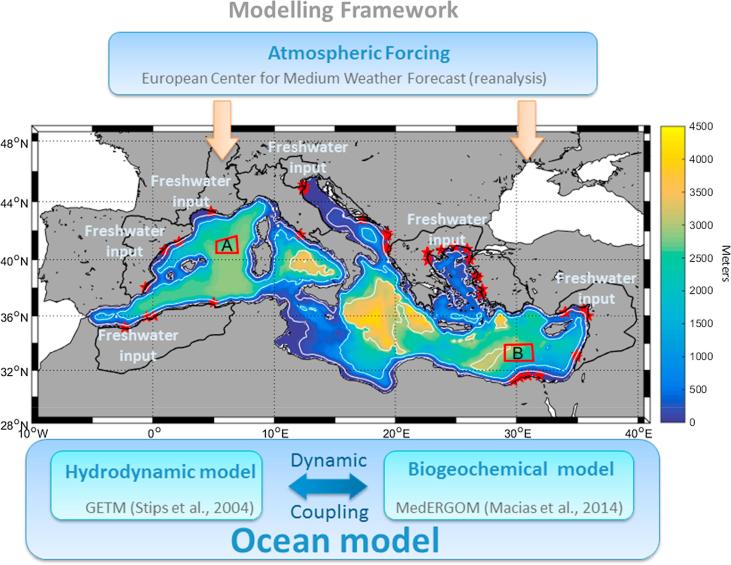
Schematic representation of the Marine Modelling Framework in its implementation to the Mediterranean Sea. Color background and white lines represent bathymetry, black lines on land represent the included rivers’ districts, red stars mark the position of the rivers mouths and red poligons (‘A’ and ‘B’) are the two open-sea selected sites for showing vertical patterns (see below). (For interpretation of the references to color in this figure legend, the reader is referred to the web version of this article.)